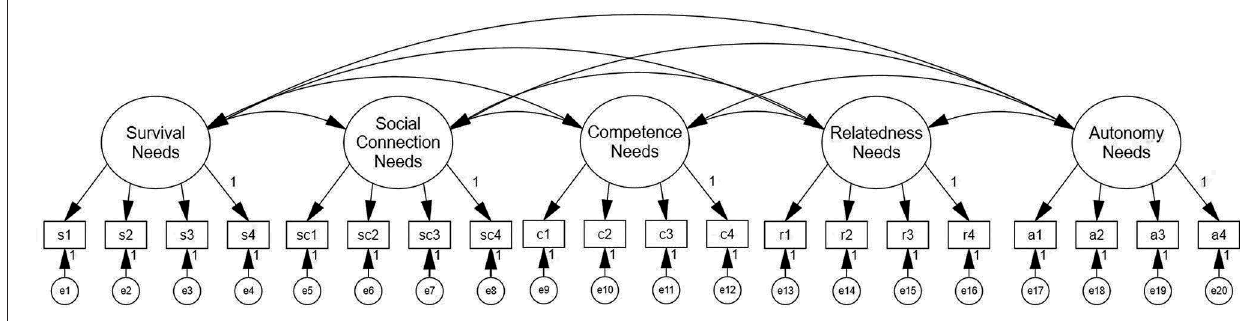
FIGURE 1 | Correlational model.